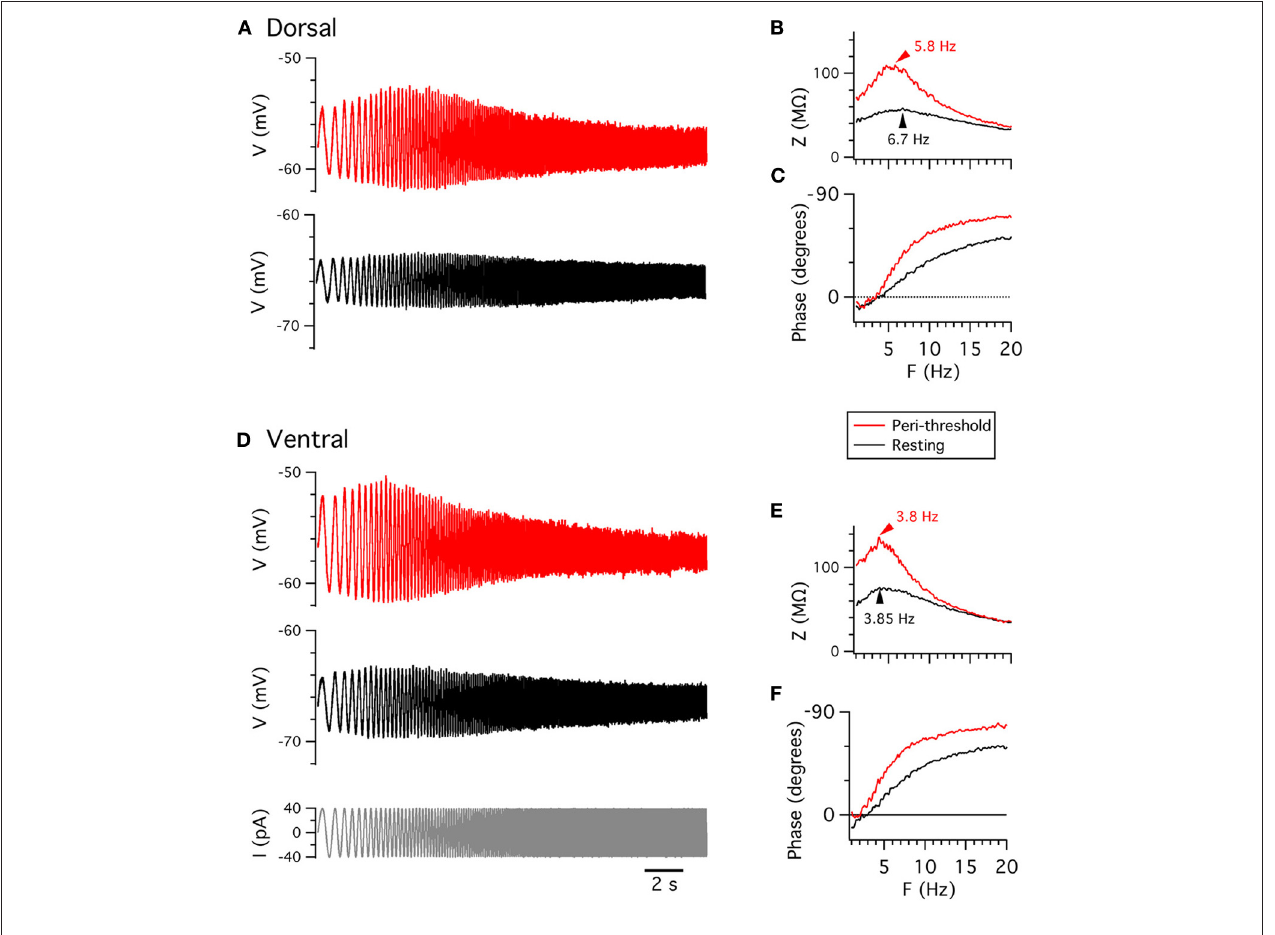
(D) stellate cells. (B,E) Membrane impedance plotted as a function of frequency. (C,F) Membrane phase plotted as a function of frequency. B,C and E,F are calculated from data in A and D ,